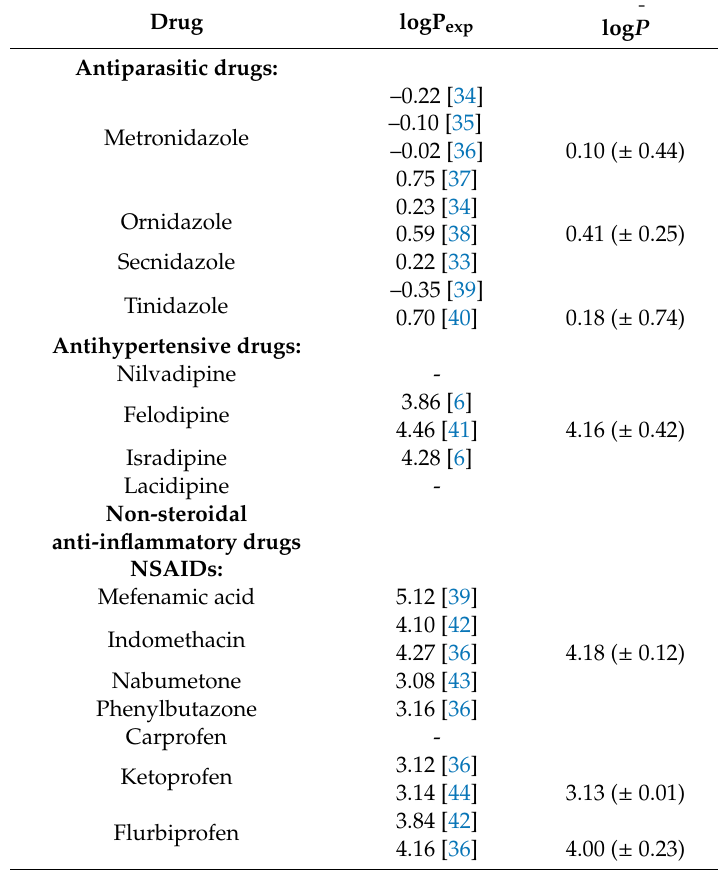
Table 4. The experimental partition coe ffi cients (logP exp ) of the examined compounds. Drug logP